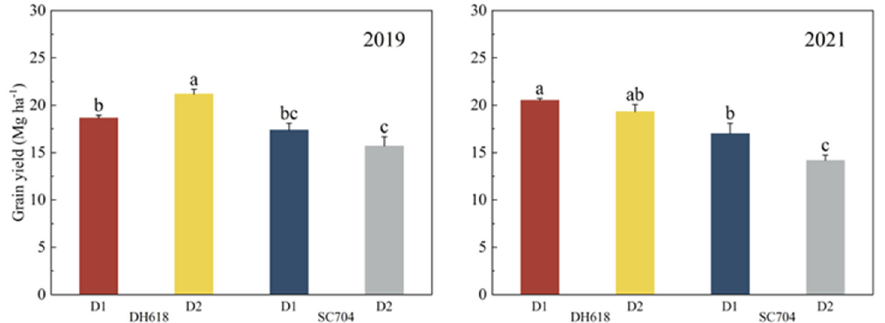
Figure 2. Grain yield for DH618 and SC704 under two planting densities, D1 (7.5 × 10 4 ) and D2 (12.0 × 10 4 ). Means in the same year not sharing any letter above the bars are significantly different by the LSD-test at the 5% level of significance.